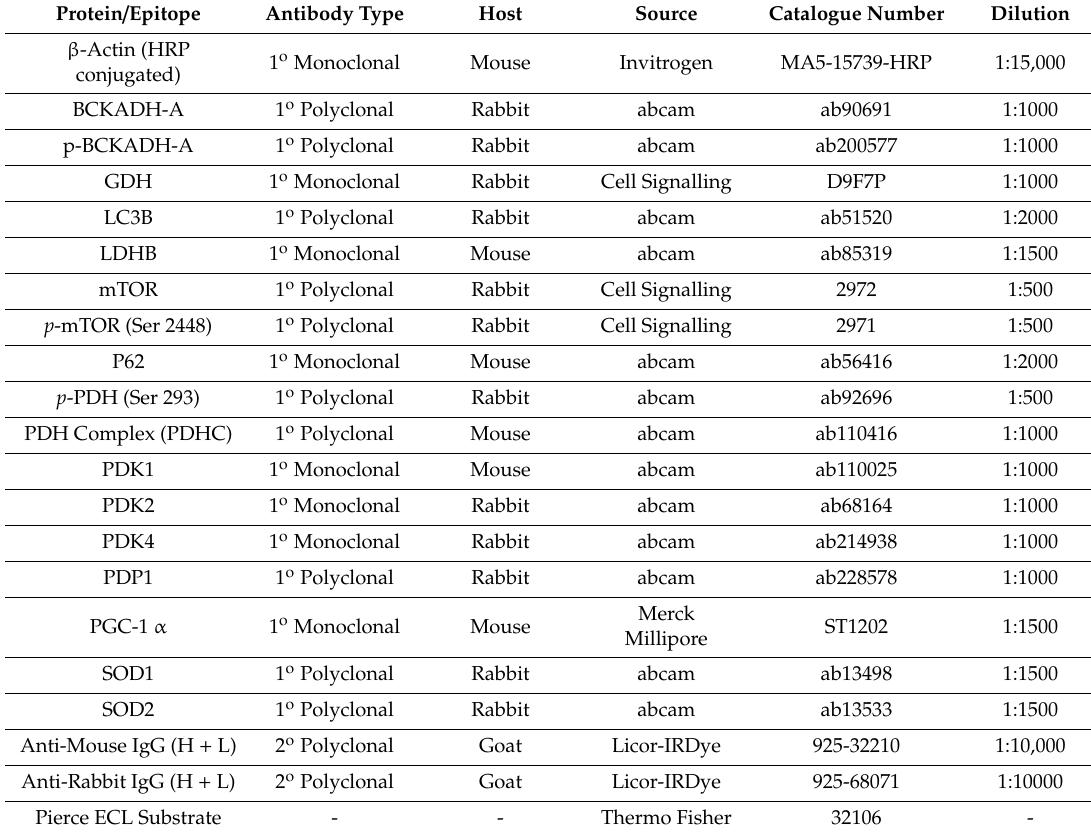
Table 1. List of antibodies and reagents used along with their usage